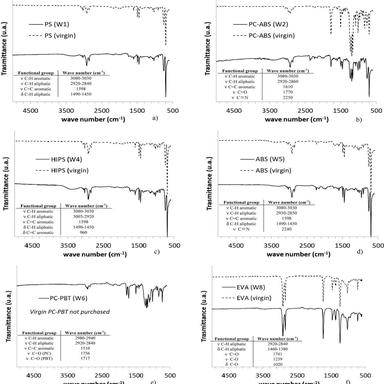
FTIR spectra of some rapresentative samples: a) PS (W1), b) PC-ABS (W2), c) HIPS (W4), d) ABS (W5), e) PC-PBT (W6), f) EVA (W8), g) PET (W8), h) PBT (W9), i) PP (W13), l) PMMA (W16), m) PC (W19) comprehensive of the main absorption bands. The broken lines relate to the equivalent virgin polymer.